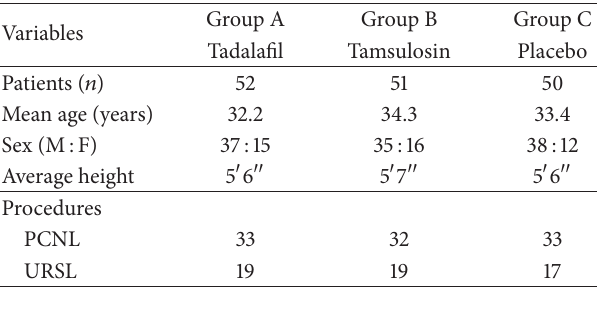
Table 1: Basic parameters of patients.